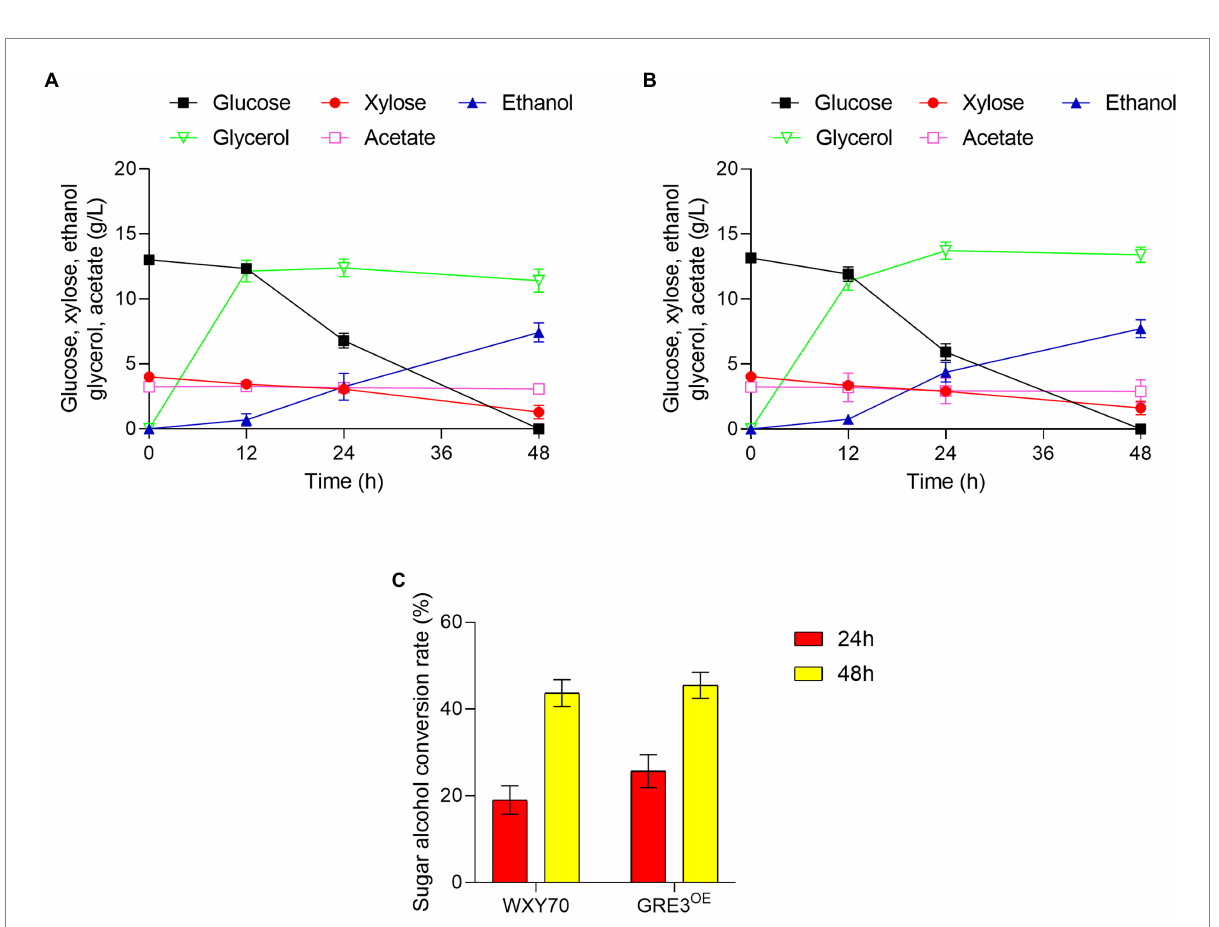
FIGURE 3 The growth and fermentation characteristics of strain WXY70 and GRE3 OE in sorghum straw hydrolysate solution. Growth and fermentation characteristics of WXY70 (A) and GRE3 OE (B) within 48 h. (C) The sugar alcohol conversion rate of WXY70 and GRE3 OE at 24 h and 48 h.